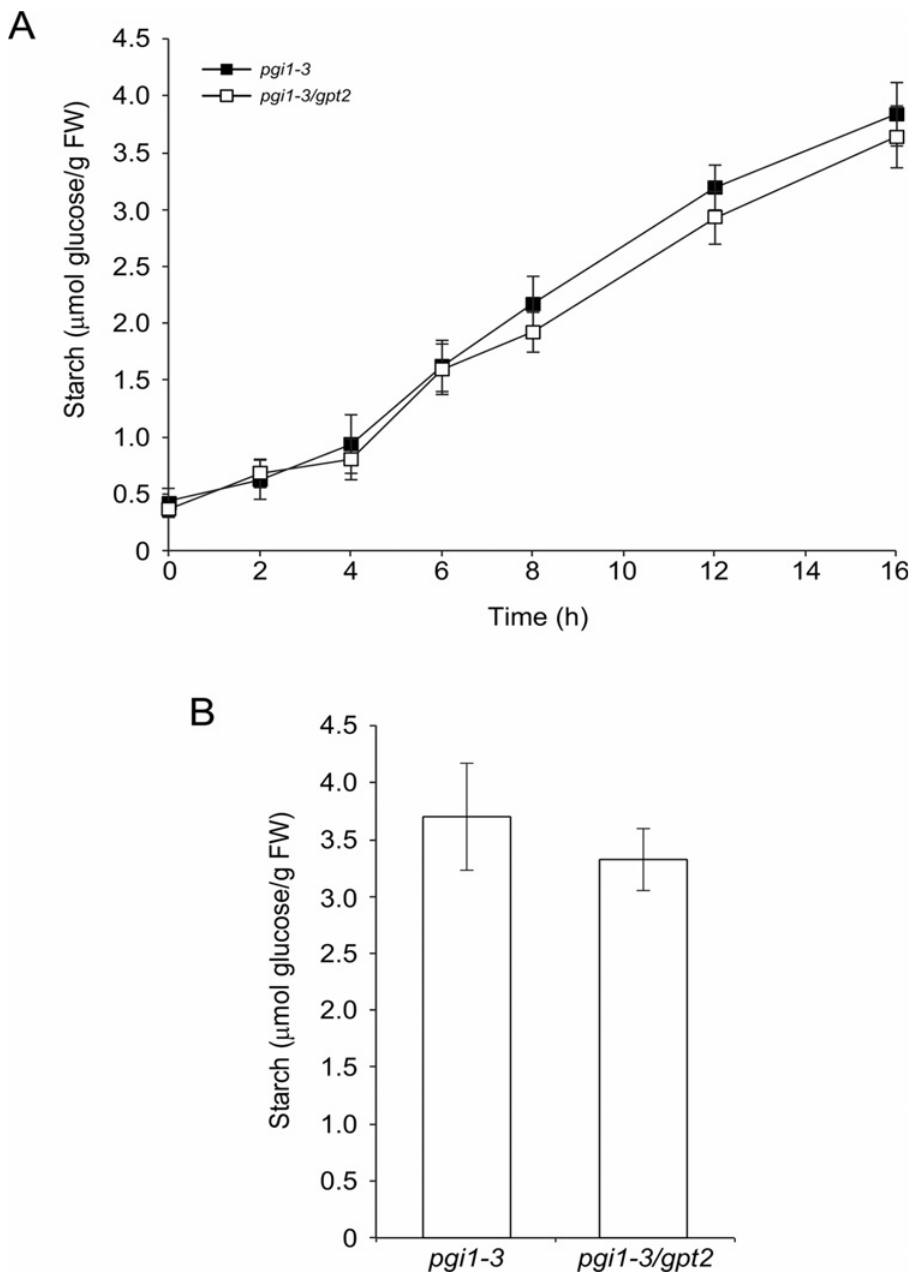
Fig 7. GPT2 is not involved in starch biosynthesis in mesophyll cells of pgi1 leaves cultured on soil under LD and CL conditions. (A) Time-course of starch content in source leaves of pgi1 – 3 and pgi1 – 3/gpt2 plants cultured under LD conditions. Essentially the same results were obtained with pgi1 – 2/gpt2 plants (not shown). (B) Starch content in source leaves of pgi1 – 3 and pgi1 – 3/gpt2 plants cultured under CL conditions. Leaves were harvested from 30 DAG plants. Values represent the mean ± SE of determinations on five independent samples. Each sample included leaves from 3 different rosettes.